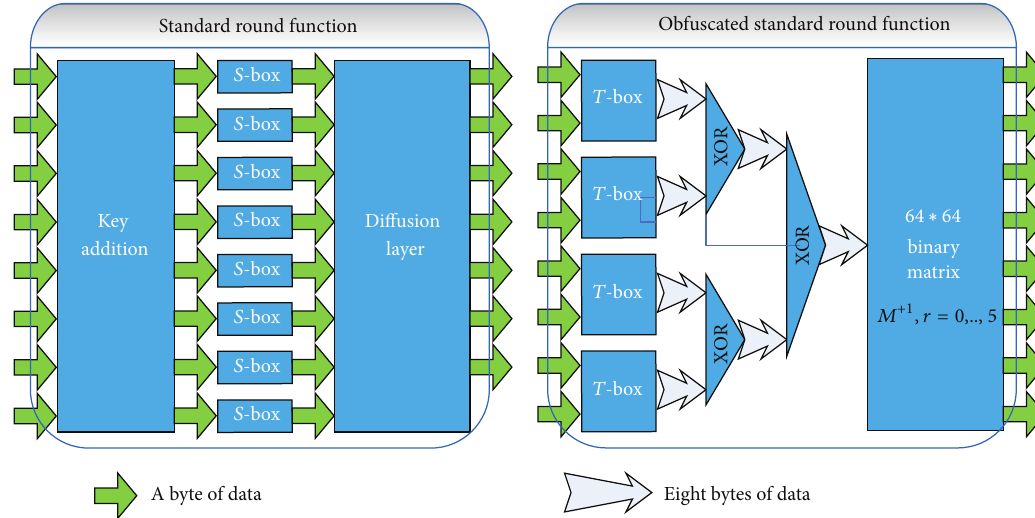
Figure 2: Data flow of the standard and the obfuscated implementation of the round functions for rounds 0 to 5.